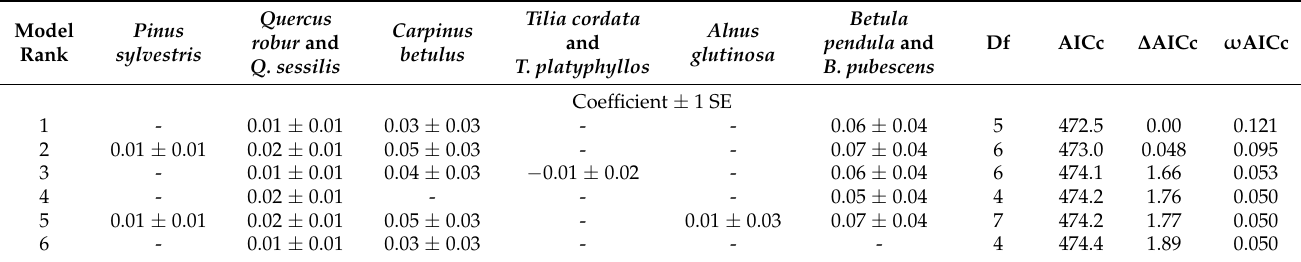
Table 4. The highest-ranking models predicting species richness of forest birds in the studied forest based on (coefficients ± 1 SE): total basal area of trees thicker than 20 cm DBH. The AICc weight ( ω AICc) for a given model indicates the probability it is the most parsimonious model.